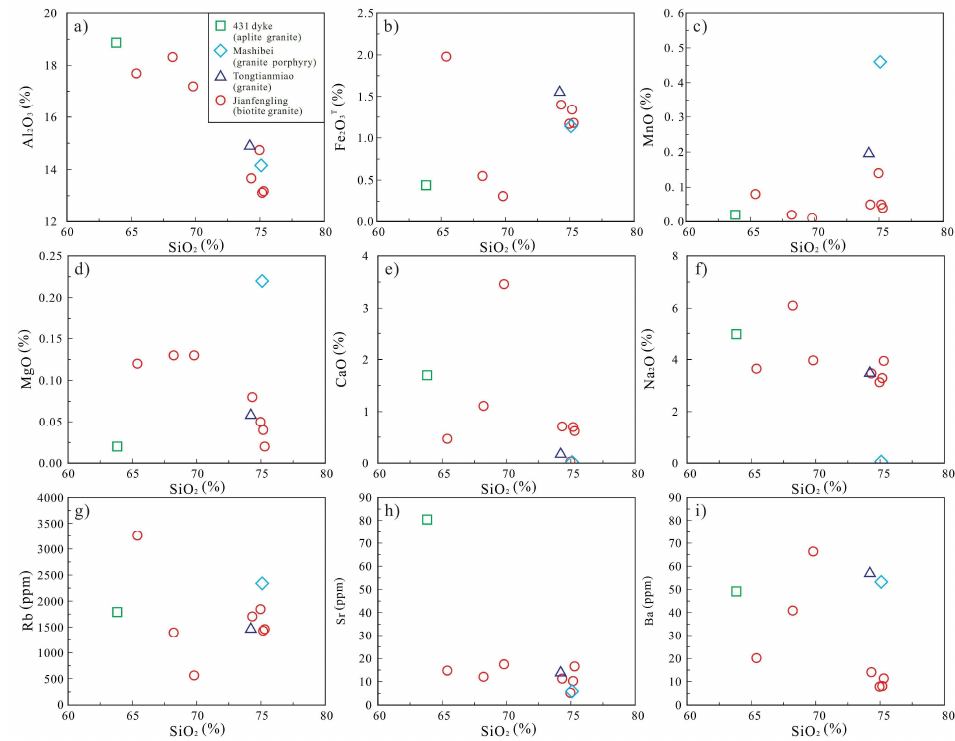
Figure 5. Plots of SiO 2 vs. ( a ) Al 2 O 3 ; ( b ) Fe 2 O 3T ; ( c ) MnO; ( d ) MgO; ( e ) CaO; ( f ) Na 2 O; ( g ) Rb; ( h ) Sr; and ( i ) Ba for the Xianghualing granitic rocks.